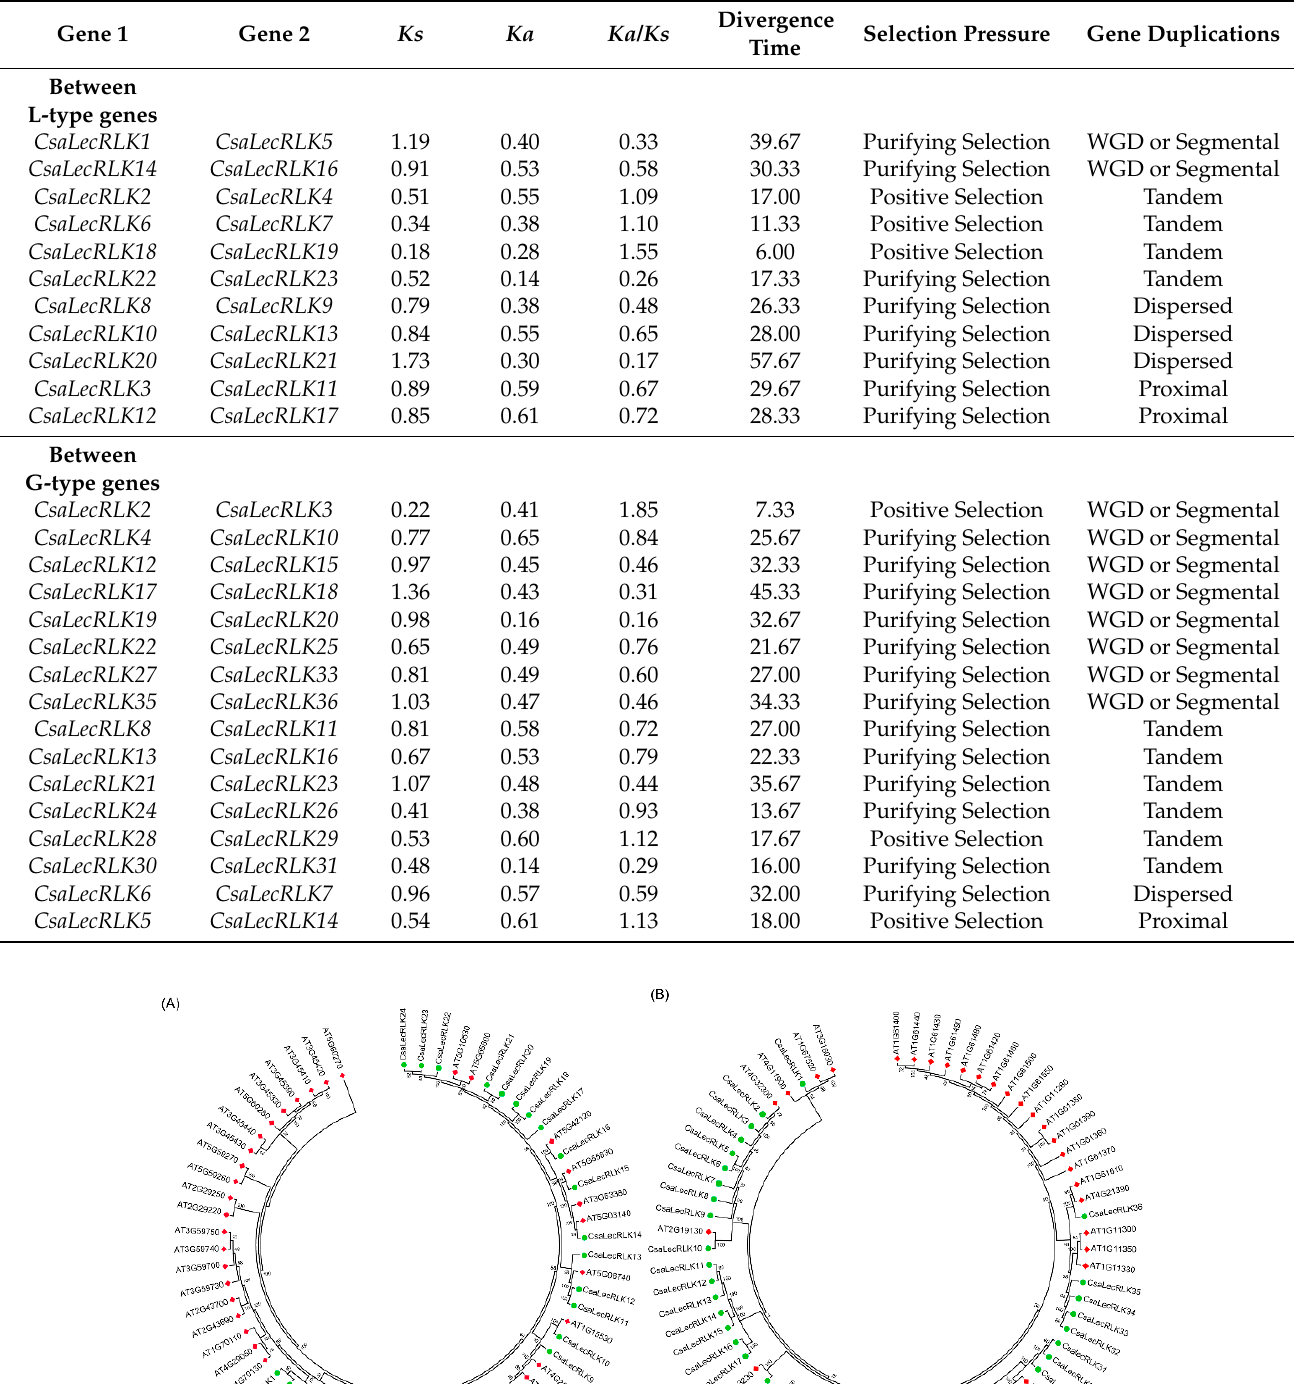
Table 1. Duplications of the LecRLK genes in Cucumis sativus .